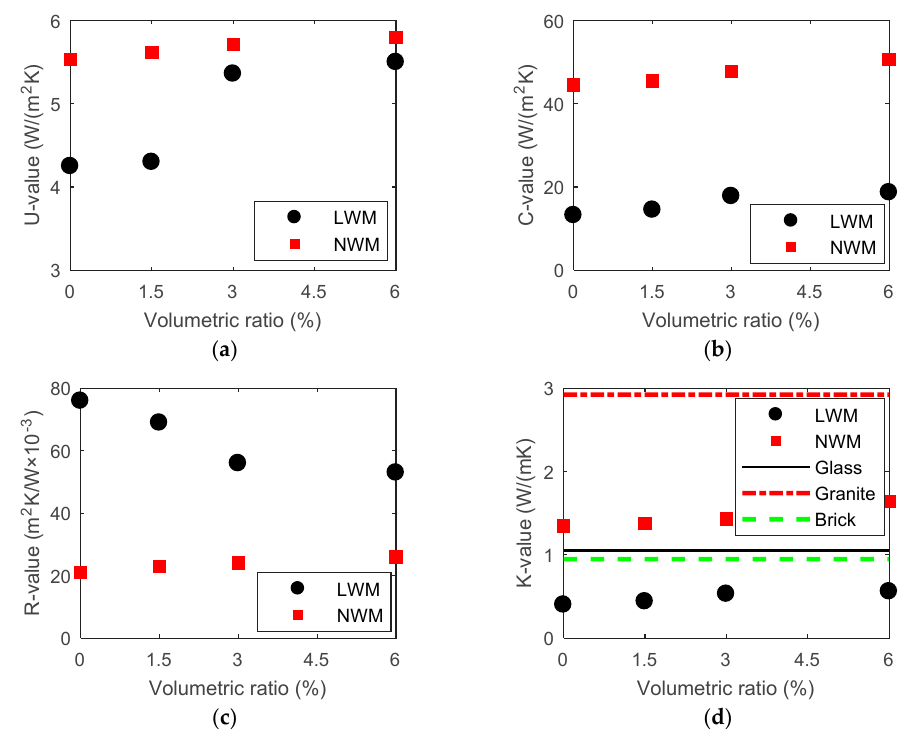
Figure 13. Outside surface temperature variation with time for each specimen.